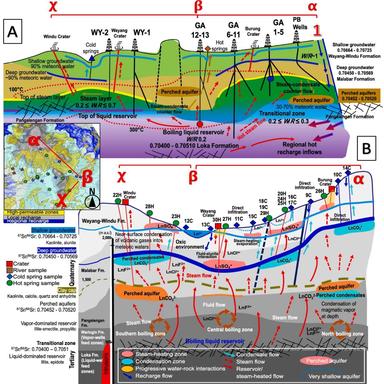
(A) Conceptual model of the recharge mechanism derived by integrating analysis results of δ2 H, δ18O, and Sr isotope compositions by and (B) improved model for the recharge and water circulation mechanisms through additional consideration of REE concentrations and speciation, which highlights the origins of the hot springs that are directly connected with the reservoir fluid. The north upflow zone has several aquitards serving as deep perched aquifers for forming LnCO3 + and LnCO3